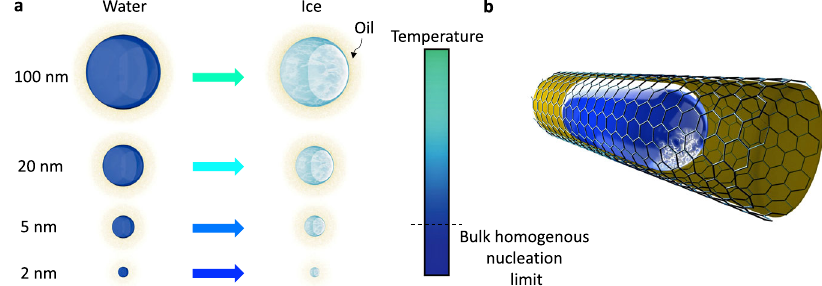
Fig. 1 Freezing of water nanodroplets. a The length dependence of water – ice transformation in a heterogeneous mode. For 2 nm water droplets, heterogeneous nucleation could break the limit of bulk homogeneous nucleation. b Schematic of a nanodroplet formed in con fi ned geometry and surrounded by an oil environment where ice nucleation occurs at the soft oil – water interface. The ice nucleation changes the local curvature of the oil – water